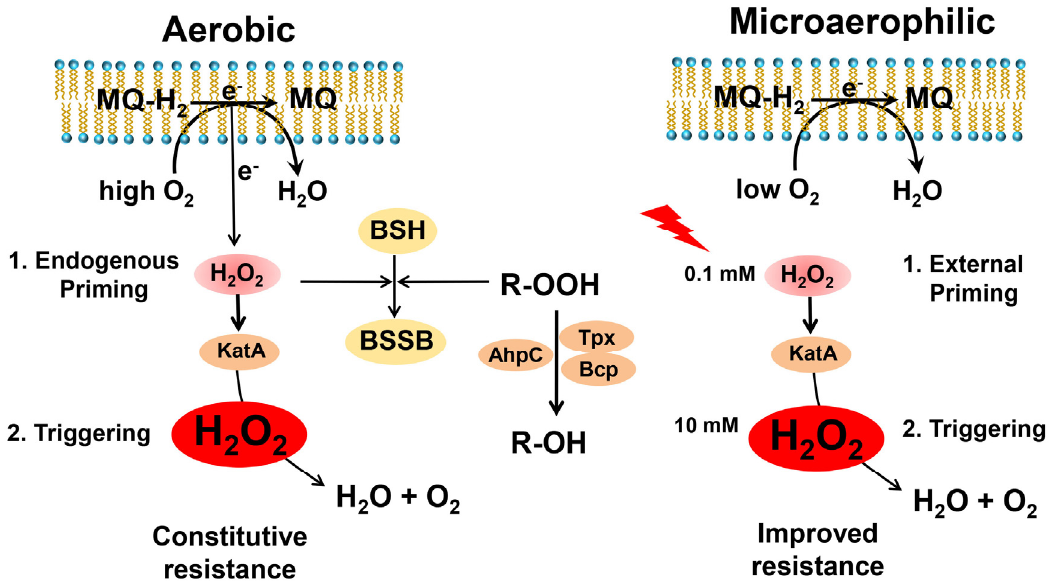
Figure 8. Summary schematics of microaerophilic H 2 O 2 priming ( right ) and constitutive aerobic H 2 O 2 resistance ( left ) in S. aureus . We found that microaerophilic priming with 100 µ M H 2 O 2 induces improved resistance towards otherwise lethal doses of 10 mM H 2 O 2 in S. aureus ( right ), while aerobic cells are already primed by endogenous ROS originating from respiration, resulting in the constitutive high H 2 O 2 resistance ( left ). The higher ROS levels during the aerobic growth were revealed by the ~20 mV increased basal E BSH compared to microaerophilic cells. The catalase KatA was shown to be induced upon microaerophilic H 2 O 2 priming ( right ) and by endogenous H 2 O 2 during aerobic respiration ( left ), mediating improved and constitutive H 2 O 2 resistance, respectively, in S. aureus . In addition, the peroxiredoxins AhpC, Tpx and Bcp were shown to confer resistance towards organic hydroperoxides (R-OOH). Furthermore, KatA and the peroxiredoxins contribute to the regeneration of reduced E BSH upon recovery from oxidative stress. MQ-H 2 and MQ indicate reduced and oxidized menaquinone. BSH and BSSB are reduced bacillithiol and oxidized bacillithiol disulfide,